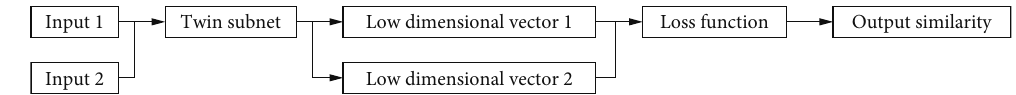
Figure 1: Standard twin neural network structure. Table 1: Datasets information.